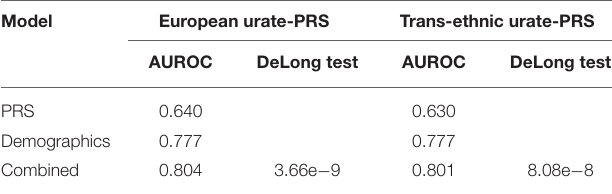
TABLE 1 | Prediction performance of three models and two